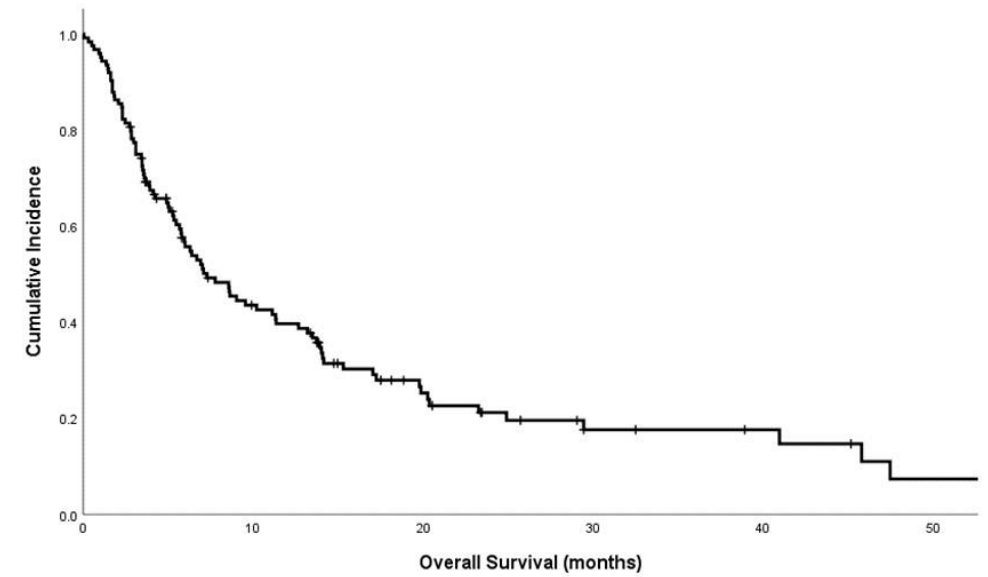
Figure 1. Kaplan–Meier plot of survival of the cohort of 124 patients. Median overall survival is 7.3 months. Two-month, six-month and twelve-month survival is 79.8%, 50.0% and 36.3%, respectively. The median total BM volume per patient was 3.4 cm 3 (range 0.1–48.2 cm 3 ) pre-HFRT, which fell significantly to 1.6 cm 3 after one month (range 0.0–45.8 cm 3 , 48.5% reduction, p